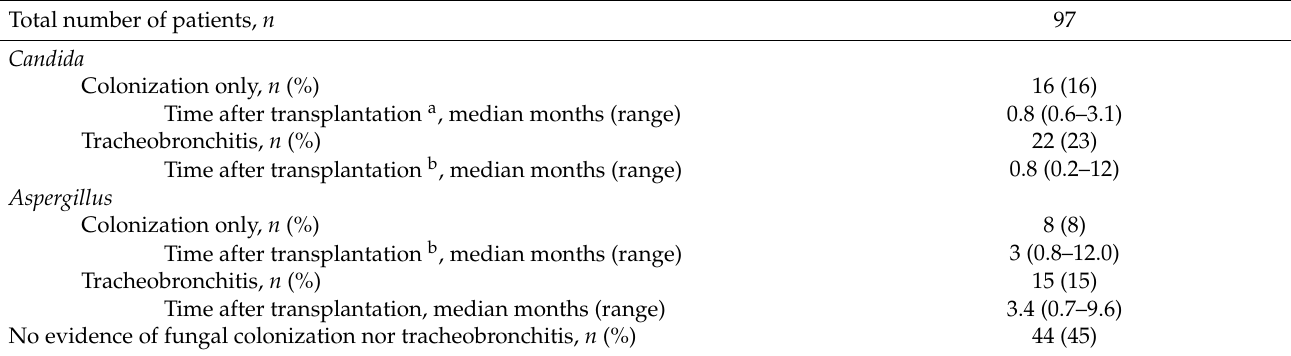
Table 2. Fungal colonization and